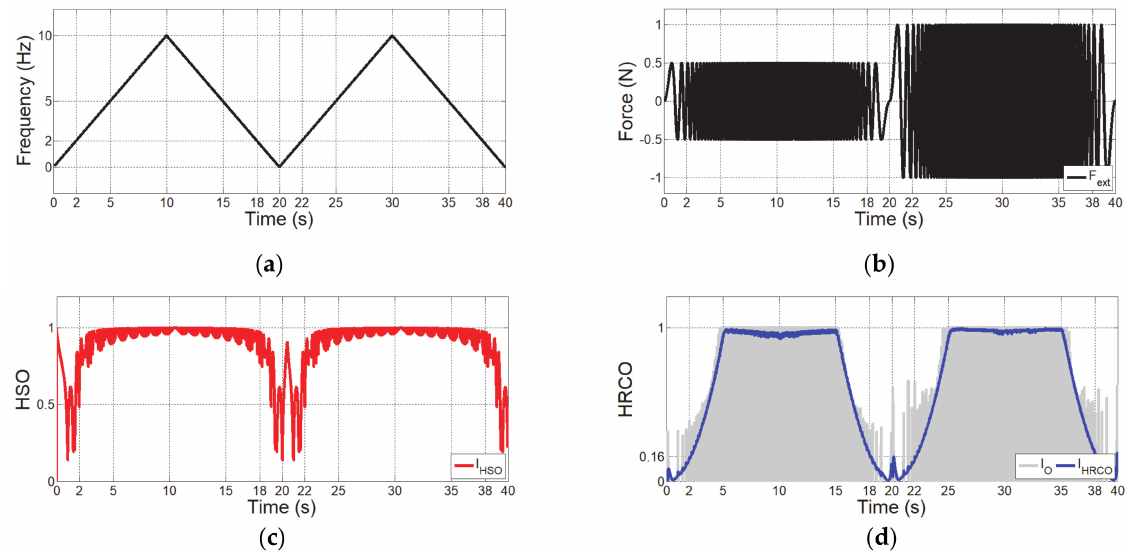
Figure 5. Simulation verification according to various magnitudes and frequencies. ( a ) Frequency of input force. ( b ) Magni- tude of input force. ( c ) I HSO output (red curve). ( d ) I O output (gray curve) and I HRCO output (blue